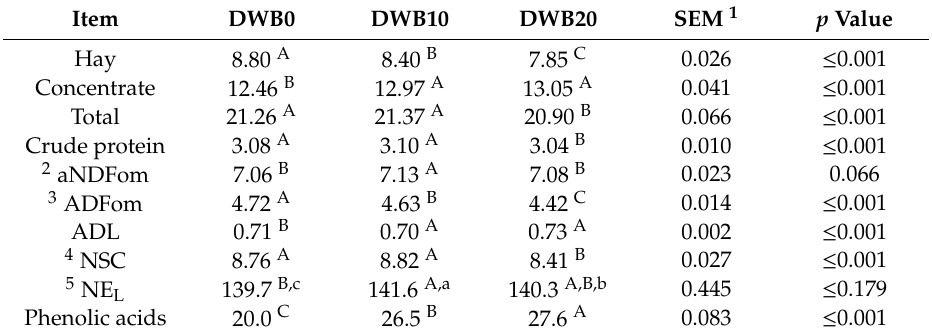
Table 3. Cows’ intake of feeds and nutrients (kg DM / day per head), net energy (MJ / day per head), and phenolic acids (g / day per head) during the